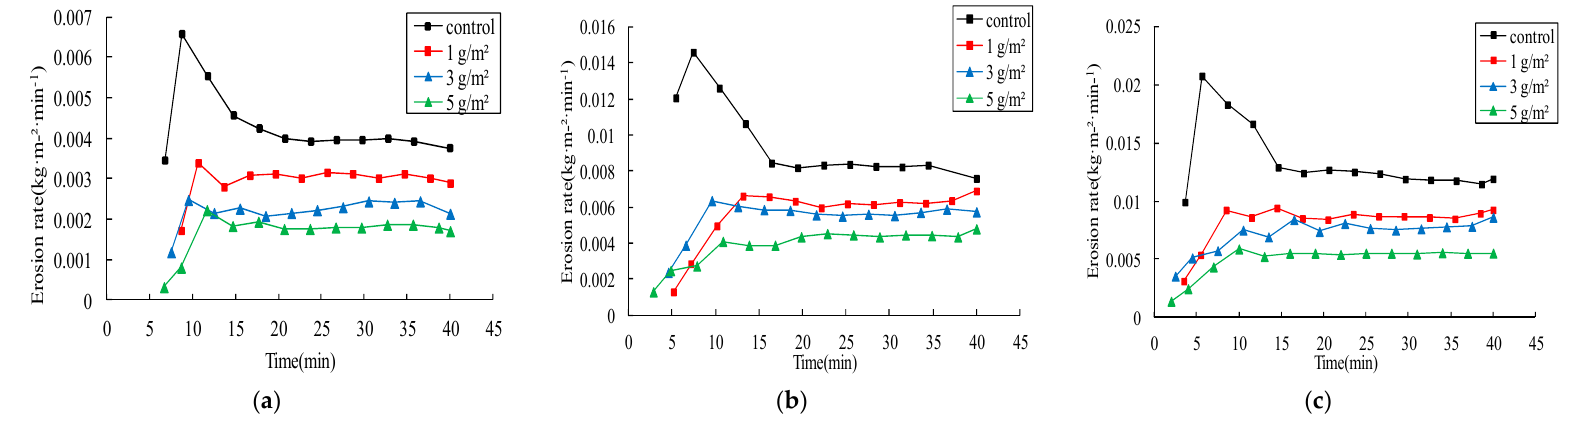
Figure 6. Erosion rates of spraying Jag C162 under three rainfall intensities. ( a ) 1.0 mm/min; ( b ) 1.5 mm/min; ( c ) 2.0 mm/min.